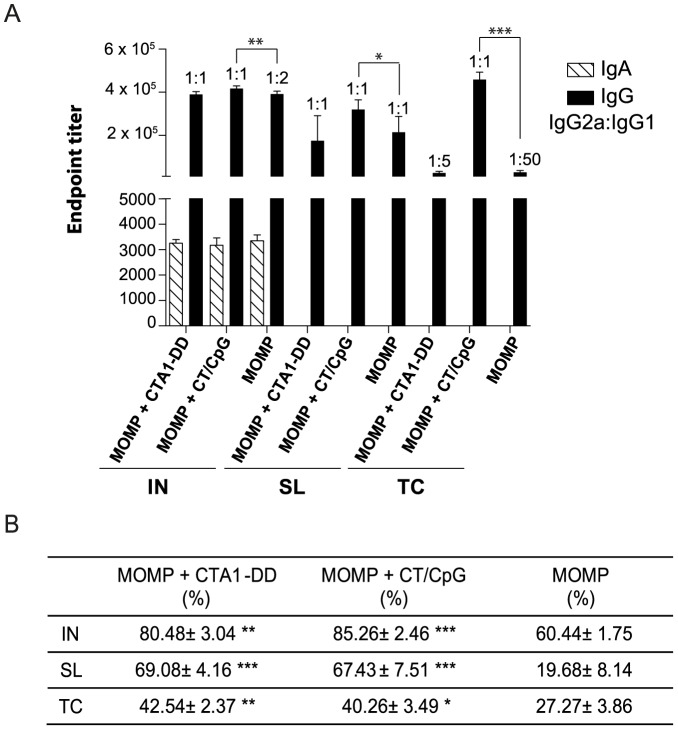
Antigen-specific systemic antibodies in serum.(A) MOMP-specific serum IgG, IgA IgG1 and IgG2a following vaccination was quantified by direct ELISA. Endpoint tires were calculated for all samples using background absorbance of PBST plus two SD. The ratio of IgG2a:IgG1, used to determine Th1:Th2 polarization, is indicated above the titer bars in each group. (B) Percentage of infection neutralized in vitro was determined by incubation of Chlamydia with a 1/10 dilution of whole serum. Results are presented as the mean ± SD. Significant differences were determined using a one-way ANOVA with Tukey’s post-test. Significance was set at P<0.05 for all tests. P>0.05 (not shown), 0.01–0.05 (*), 0.001–0.01 (**) and <0.001 (***).